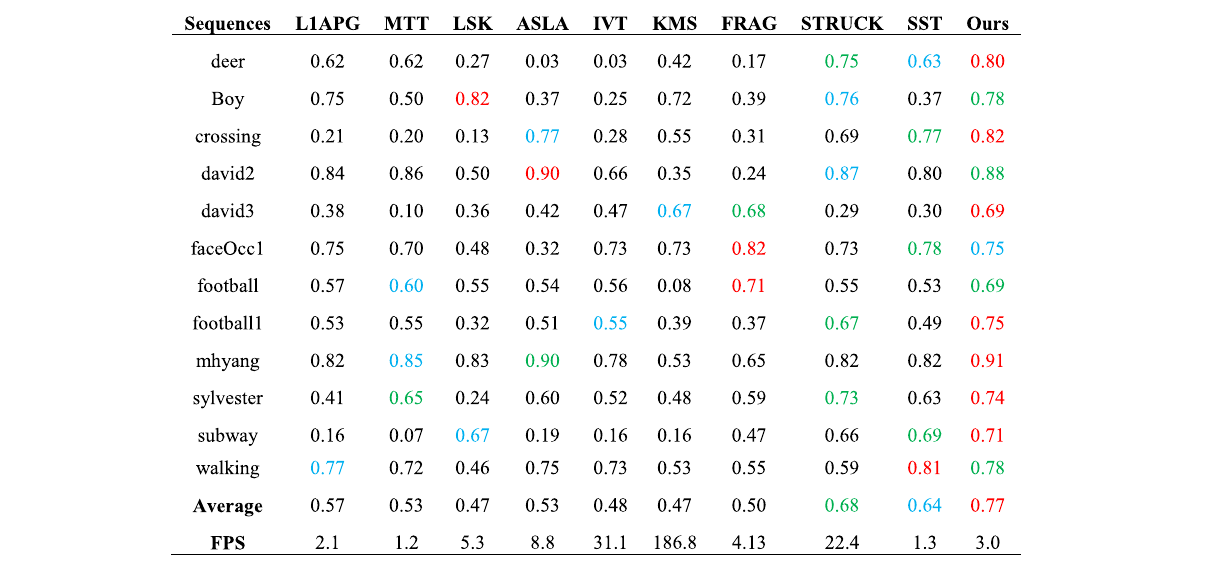
Table 3 Average overlap rate for each sequence with 9 state-of-the-art trackers. The last row shows comparison results regarding the computational loads in terms of